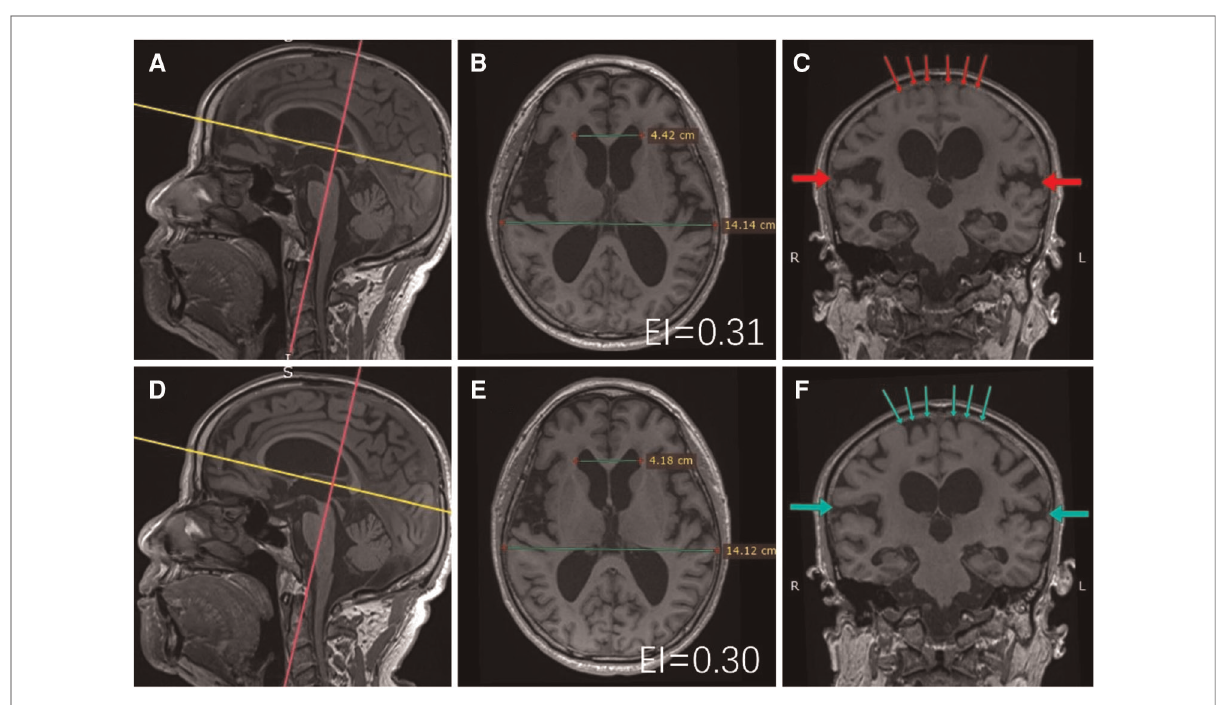
FIGURE 2 A 72-year-old male patient underwent T1-weighted thin-layer head MRI scans before and after surgery. Multiplanar reconstructions of the data are shown above. Preoperative: ( B,C ) were reconstructed along the yellow and pink lines of ( A ), respectively; Postoperative: ( E,F ) were reconstructed along the yellow and pink lines of ( D ), respectively. EI measurements (EI is the ratio of the maximal distance of frontal horns to the maximal inner diameter of the skull on the same plane) were performed at the same transversal planes, the postoperative ( B ) EI decreased compared with that of preoperative ( E ); Signs of DESH were observed in the same coronal planes, the degree of postoperative convex subarachnoid space tightness (green thin arrows of F ) was reduced compared with that of preoperative (red thin arrows of C ), and the degree of postoperative Sylvian fi ssure enlargement [green thick arrows of ( F )] was reduced compared with that of preoperative [red thick arrows of ( C )]. The patient ’ s preoperative mRS was level 4, which improved to level 1 one year after LPS